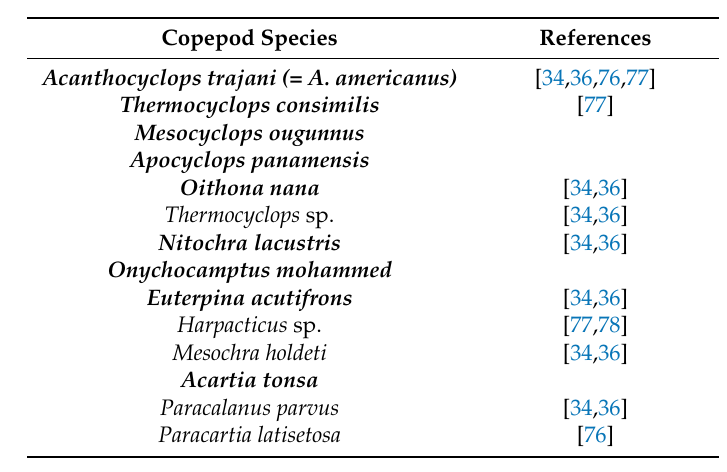
Table 4. Occurrence of copepod species in Lake Manzalah in comparison with previous studies (references are indicated). The bold lettering evidences the species of the present